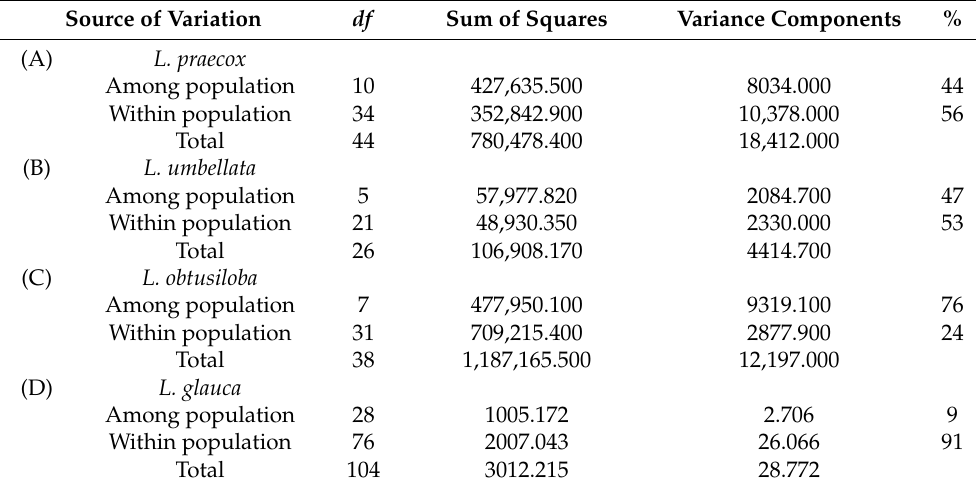
Table 5. Analysis of Molecular Variance (AMOVA) results for the studied four Lindera populations.